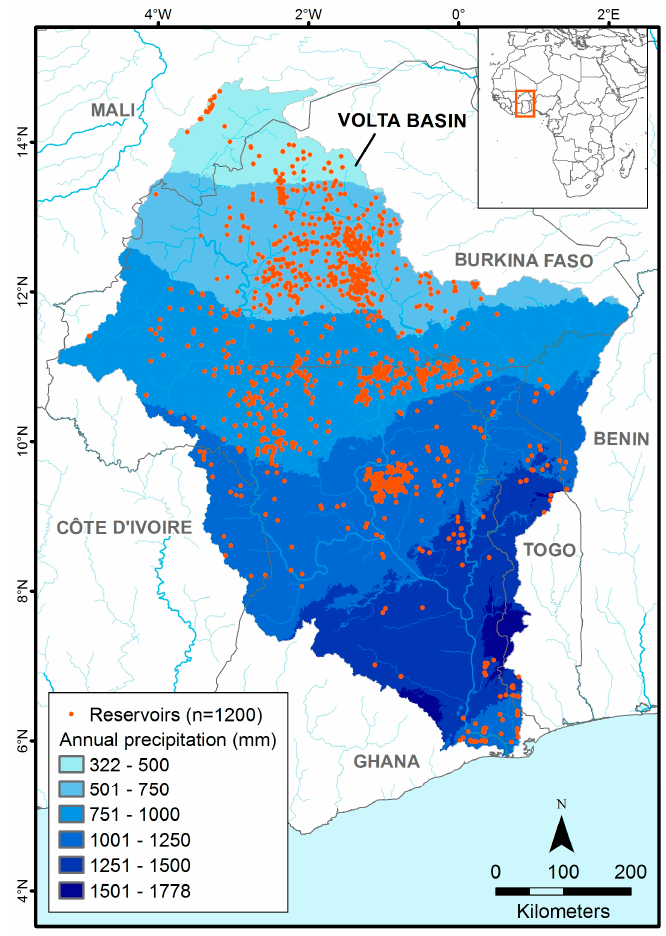
Figure 1. Annual precipitation over the Volta basin study site based on 1980–2010 WorldClim data, with reservoirs identified in this study from Google Earth imagery.